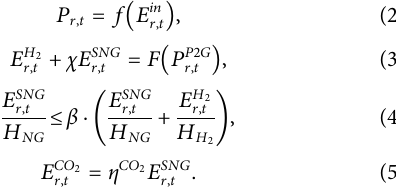
FIGURE 2 Linearization of the characteristic curve of RSOC during steady-state operation. (A) power generation mode, (B) electrolysis